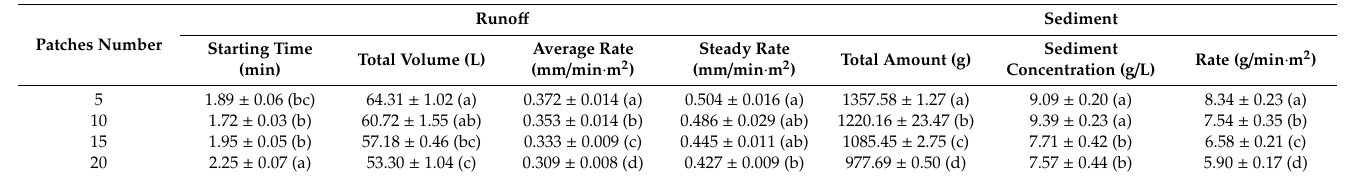
Table 5. Run-o ff and sediment yields for the di ff erent numbers of vegetation patches under simulated rainfall.